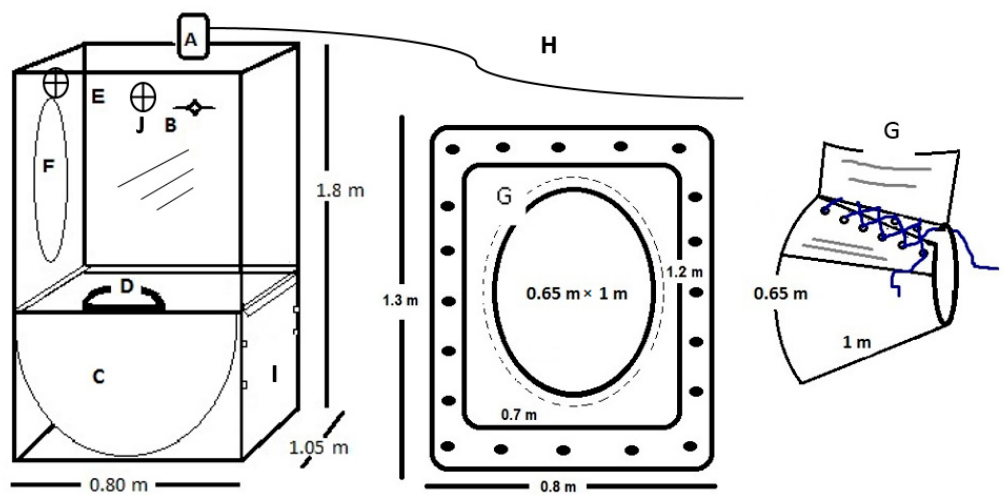
Figure 2. Schematic of the head-box: ( A ) Air outlet connecting to the mass flow generator (FK-500); ( B ) Air inlet valve; ( C ) Feeder; ( D ) Automated drinking water bowl; ( E ) Transparent acrylic walls (0.6 cm thick); ( F ) Hood hole; ( G ) Hood; ( H ) Insulated hose that connects the head-box with the mass flow